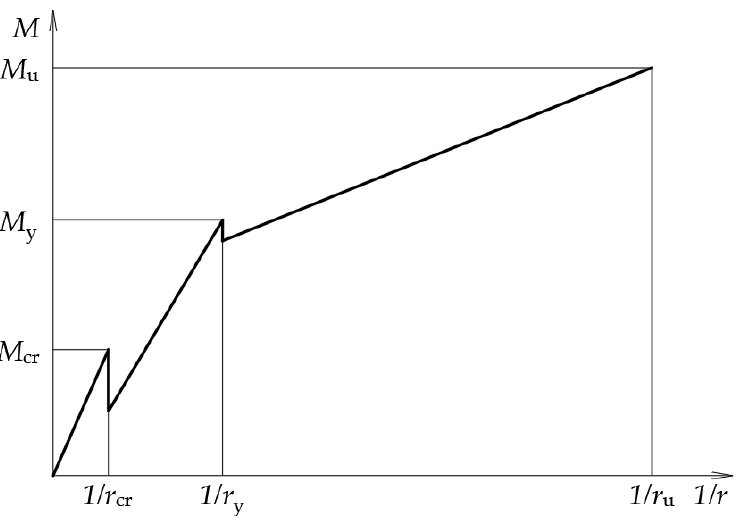
Figure 4. Bending moment–curvature diagram for FRP reinforced section with a confined compres- sion area. sion